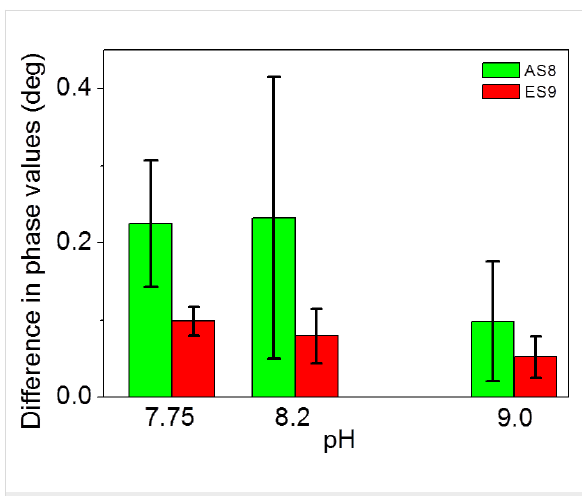
Figure 7: Evaluation of the phase difference prior and after injection of peptides as shown in Figure 6 A,C,D. For experimental values, see Supporting Information File